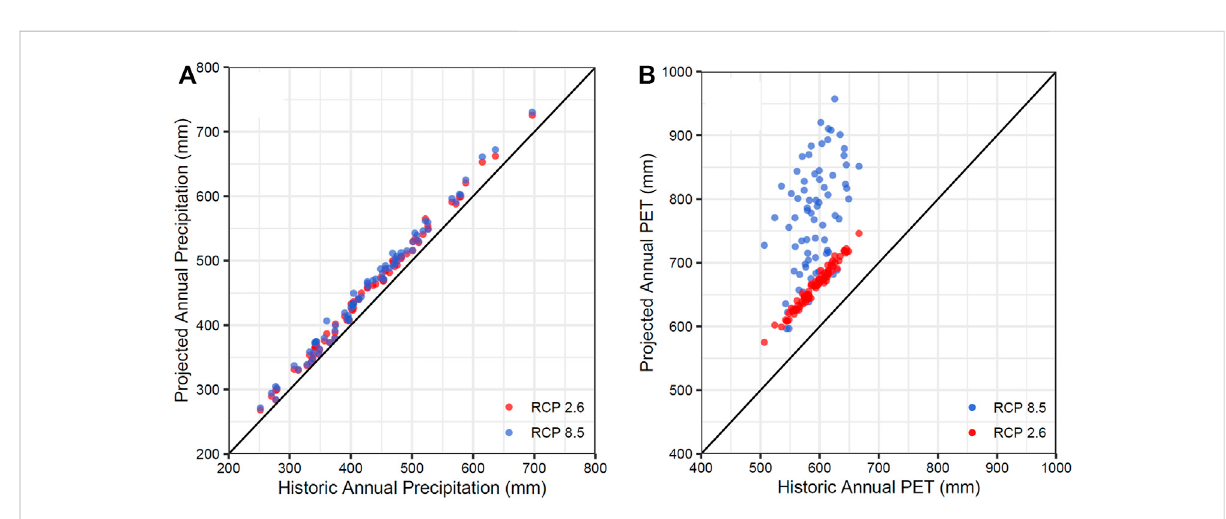
FIGURE 6 Annual (A) precipitation and (B) potential evapotranspiration (PET) — historical measured versus projected for RCP2.6 and RCP8.5 dry climate